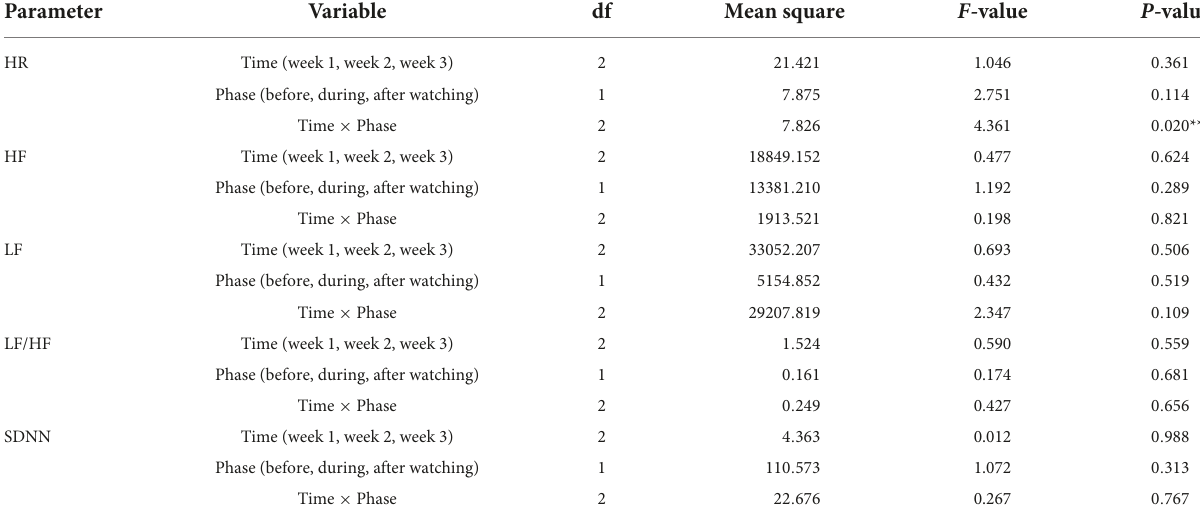
TABLE 4 The two-way repeated measures ANOVA of different week and physiological parameters before and after watching video. Parameter Variable df Mean square F -value P -value